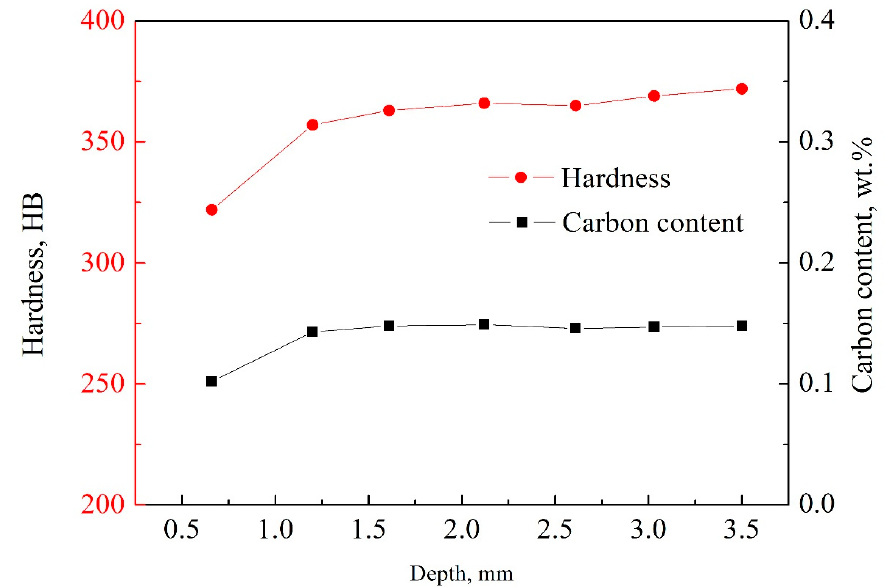
Figure 4. Curves of hardness and carbon content with depth.